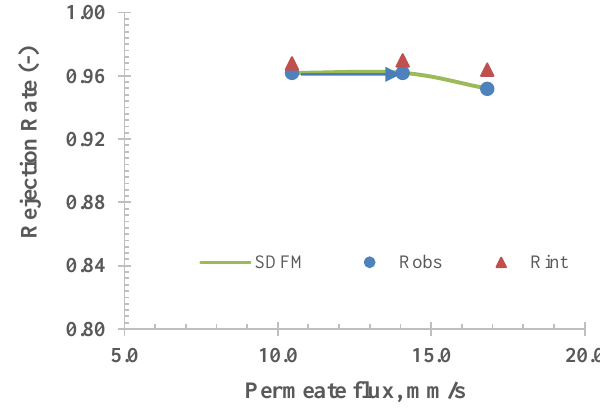
Fig 4. Fitting of Observable Rejection Rate experimental (circle) and intrinsic rejection rate (triangular) with SDFM (continuous line). (Testing condition: P = 10 bar, CFV = 0.65 m/s, MgCl 2 concentration = 607.07 ± 35.23 ppm, and pH = 6.42 ± 0.17, T = 20 – 40